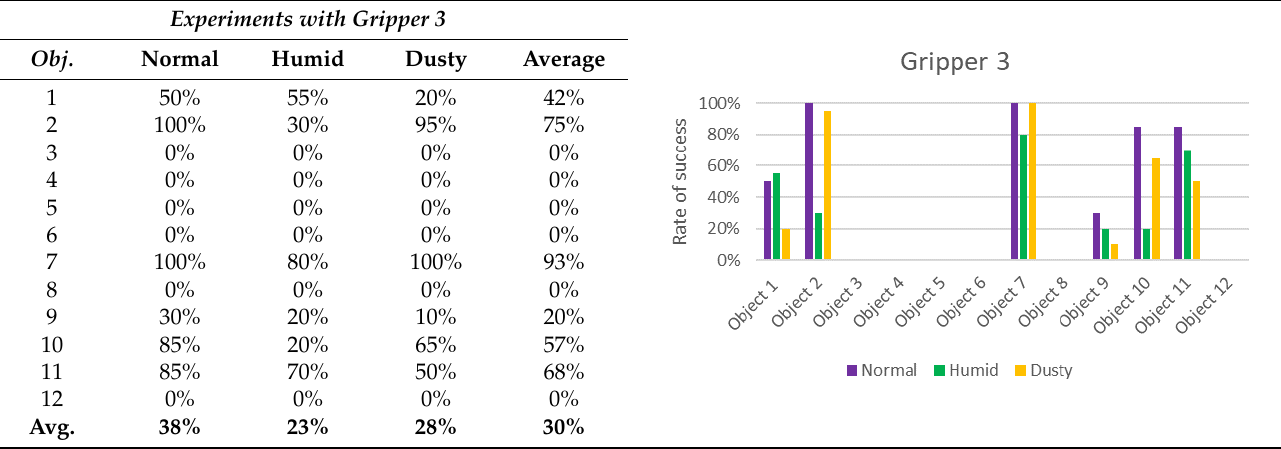
Table 4. Experiments with Gripper 3. On the left, the table with success rate for every object, in the last column, the average for every object is calculated, and at the end of the table, the average success rate for every environment is determined. On the right, the graphic representation of Table 4 is